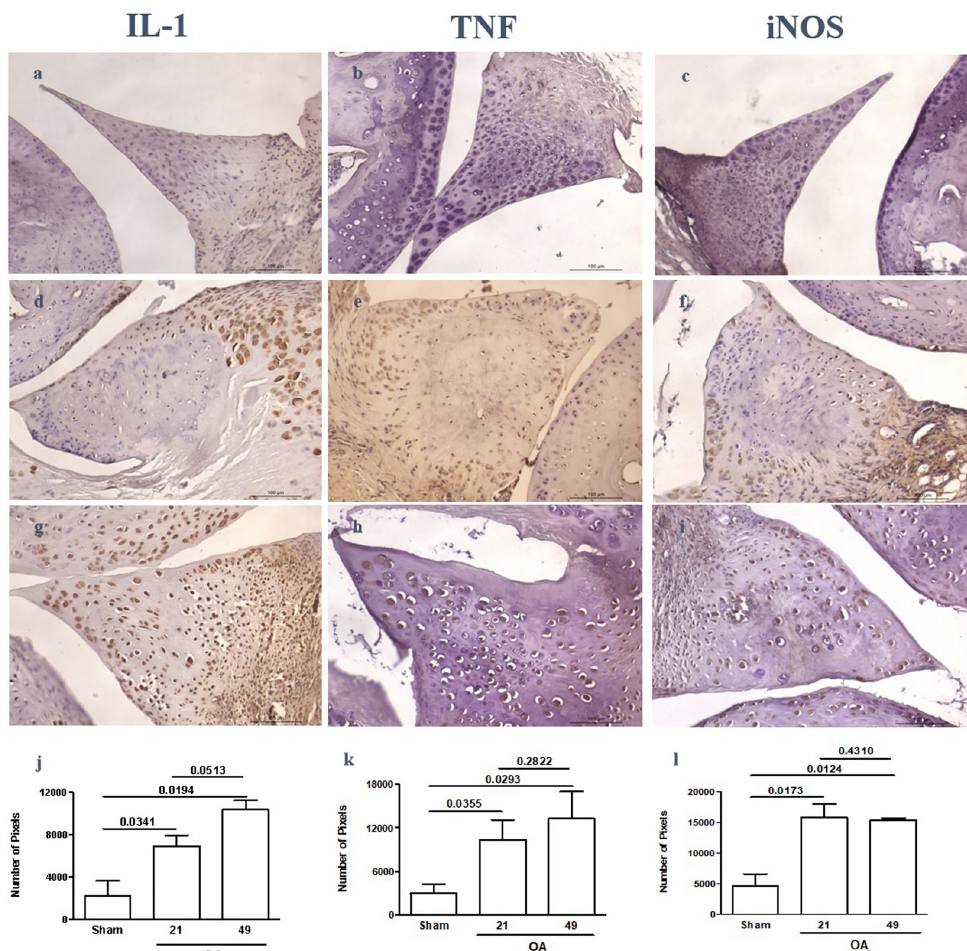
Fig 4. Representative illustration of the immunoexpression of IL-1 β , TNF, and iNOS in mouse menisci subjected to postsurgical experimental OA or a sham procedure. While mostly cells closer to the “red zone” of the meniscus stain positive in sham samples (a,b,c) there is diffuse immunoexpression in samples from OA groups sacrificed 21 (d,e,f) or 49 (g,h,i) days after surgery. Quantitation of immunoexpression from 3 independent experiments reveals significantly increased immunoexpression in OA samples, as compared to sham (j,k,l); original magnification × 400.